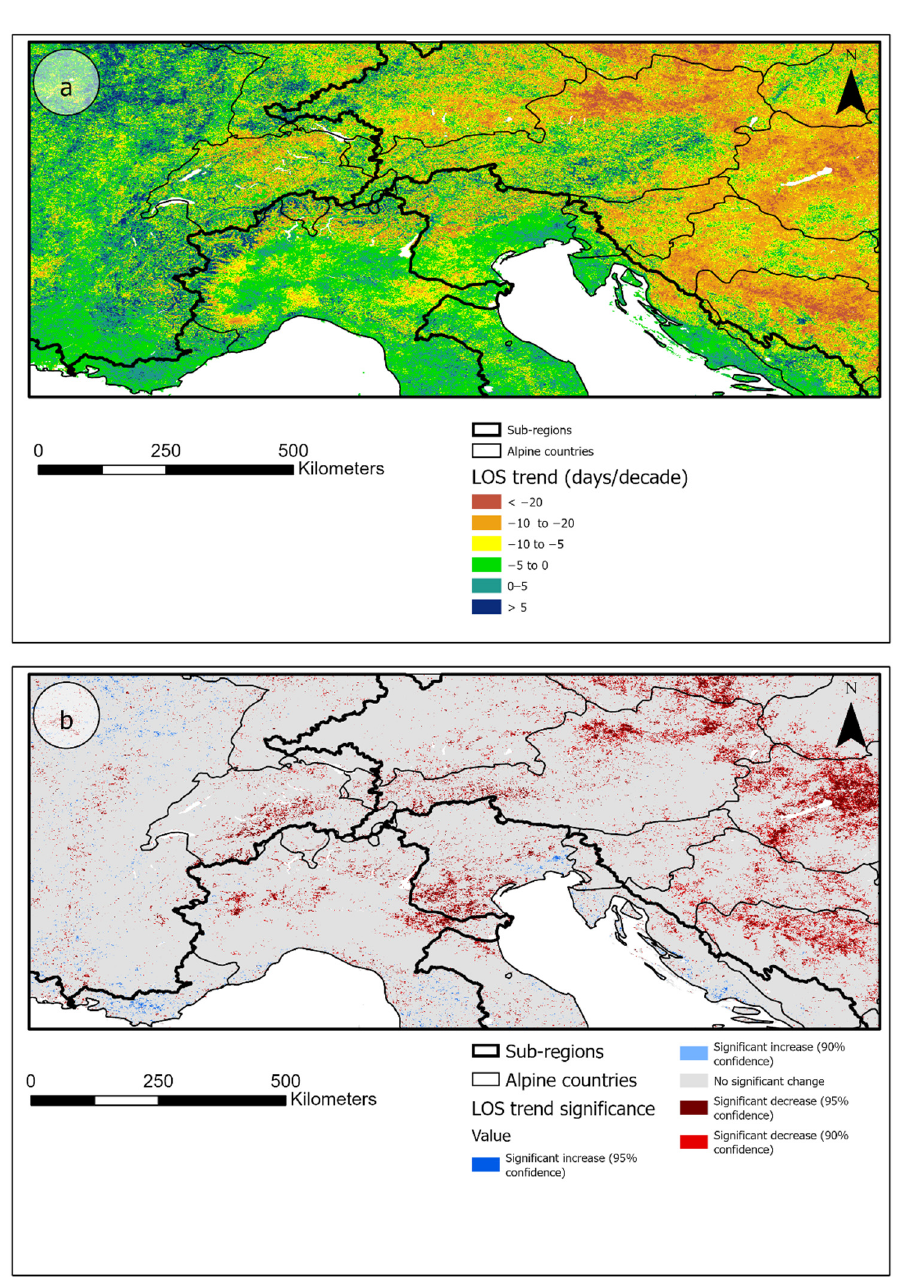
Figure 9. ( a ): trend in the length of season (LOS) in days per decade in the Greater Alpine region from 2000 to 2019. ( b ): significance of the trends in the LOS over the GAR.